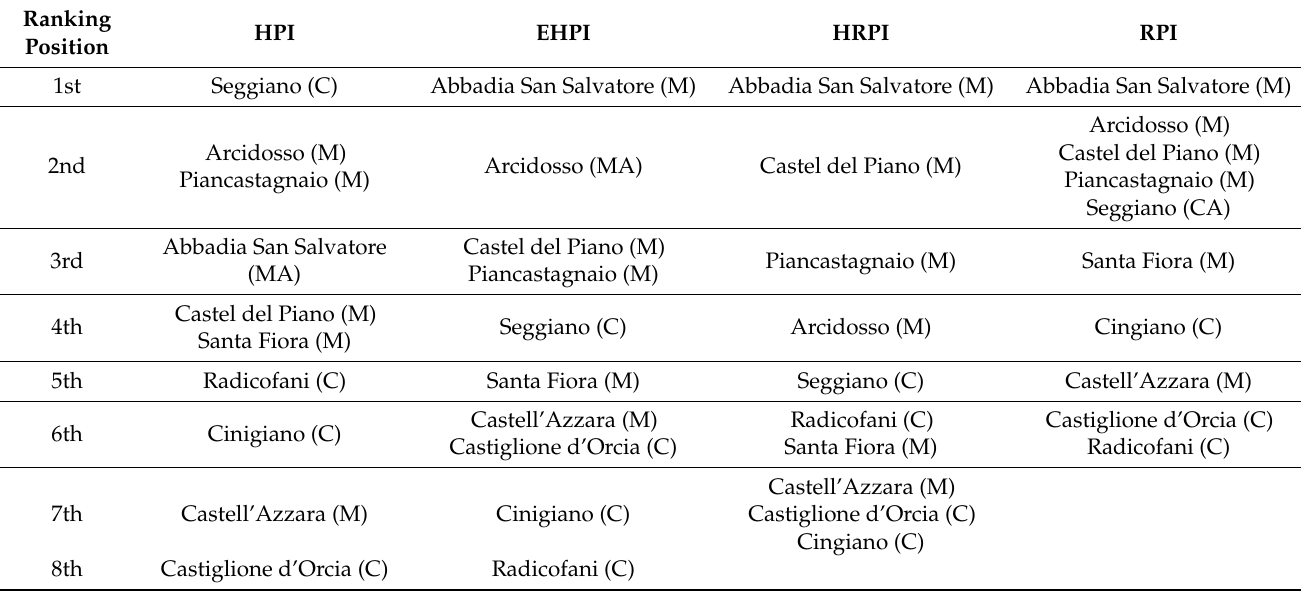
Table 6. Ranking in descending order of the risk perception indices by municipality of